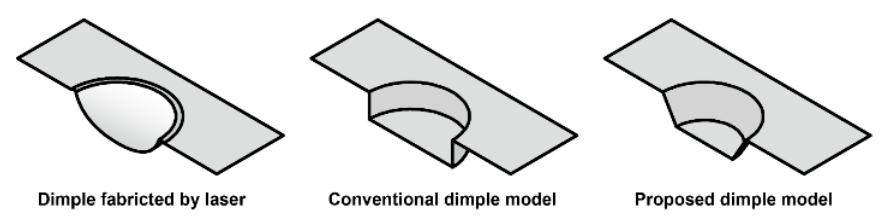
Figure 3. Images of dimples fabricated by a laser texturing process on steel, drawn based on the published information [12], the conventional model, and proposed dimple model.